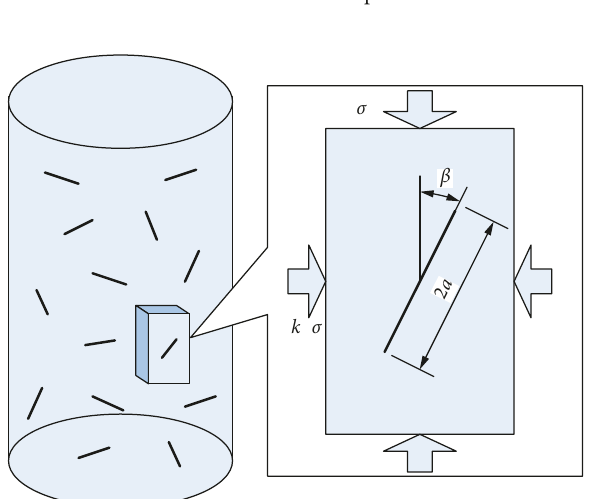
Figure 3: Internal stress state of the rocks near the microcrack.